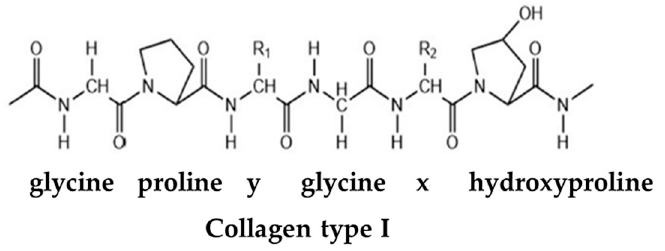
Figure 18. The structure of collagen type I.